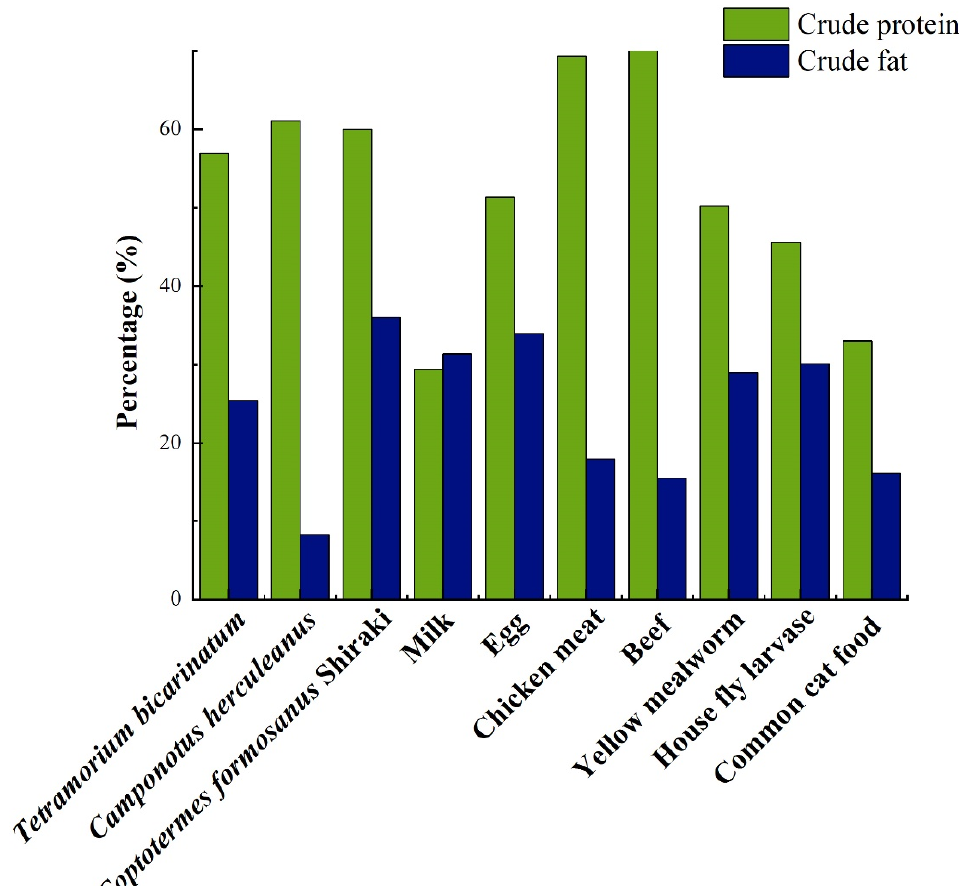
Figure 1. Macronutrient concentrations in natural and other feeds of pangolins (dry weight) [22,30,31]. Notes: The other feeds include milk, egg, chicken meat, beef, yellow mealworm, house fly larvase and common cat food.